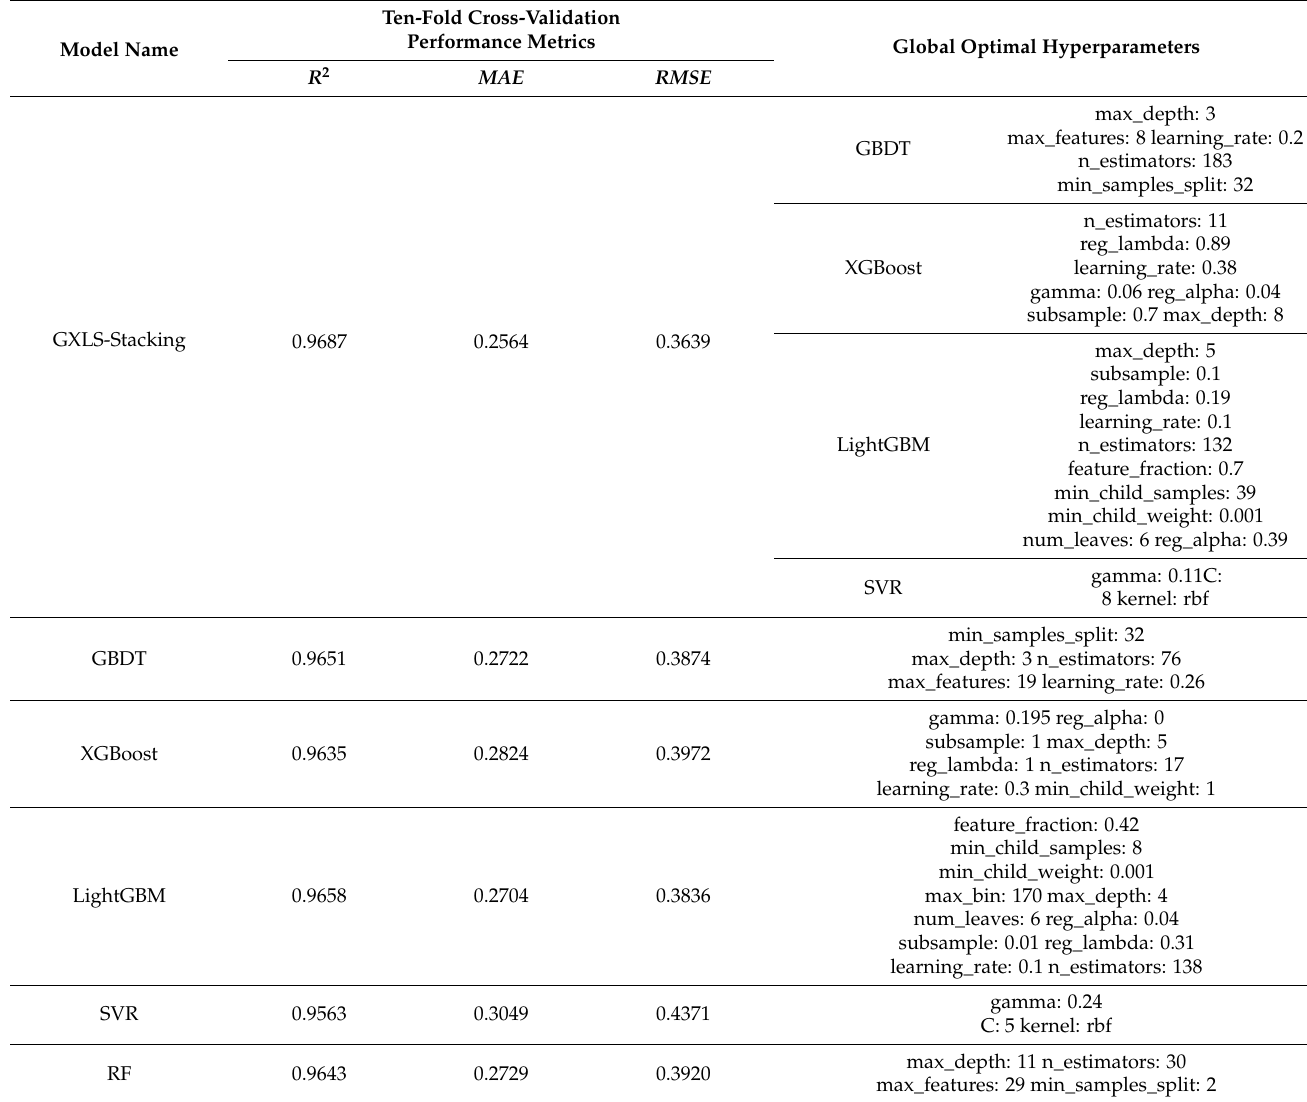
Table 3. The hyperparameters of the optimal models and their performance metrics in the ten-fold